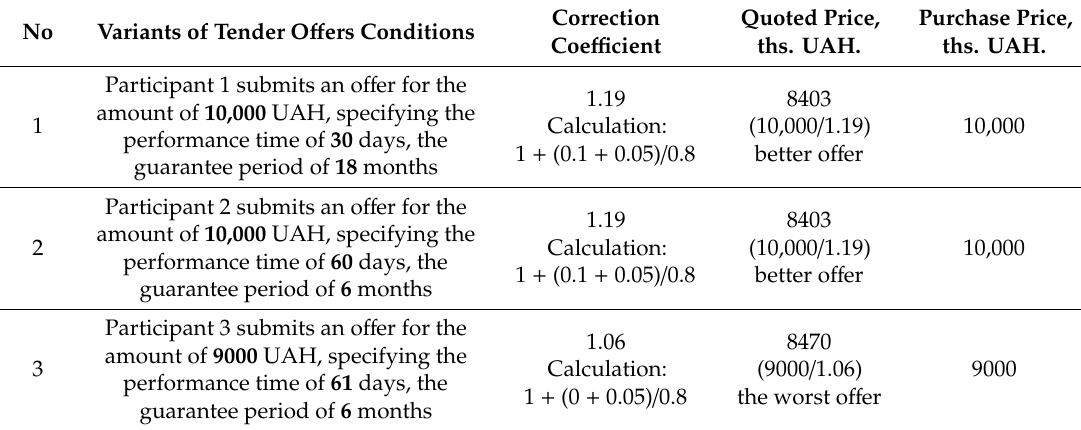
Table 4. Obtained results of the evaluation of the quoted price under di ff erent variants of the tender o ff er, according to the recommended method (MEDT